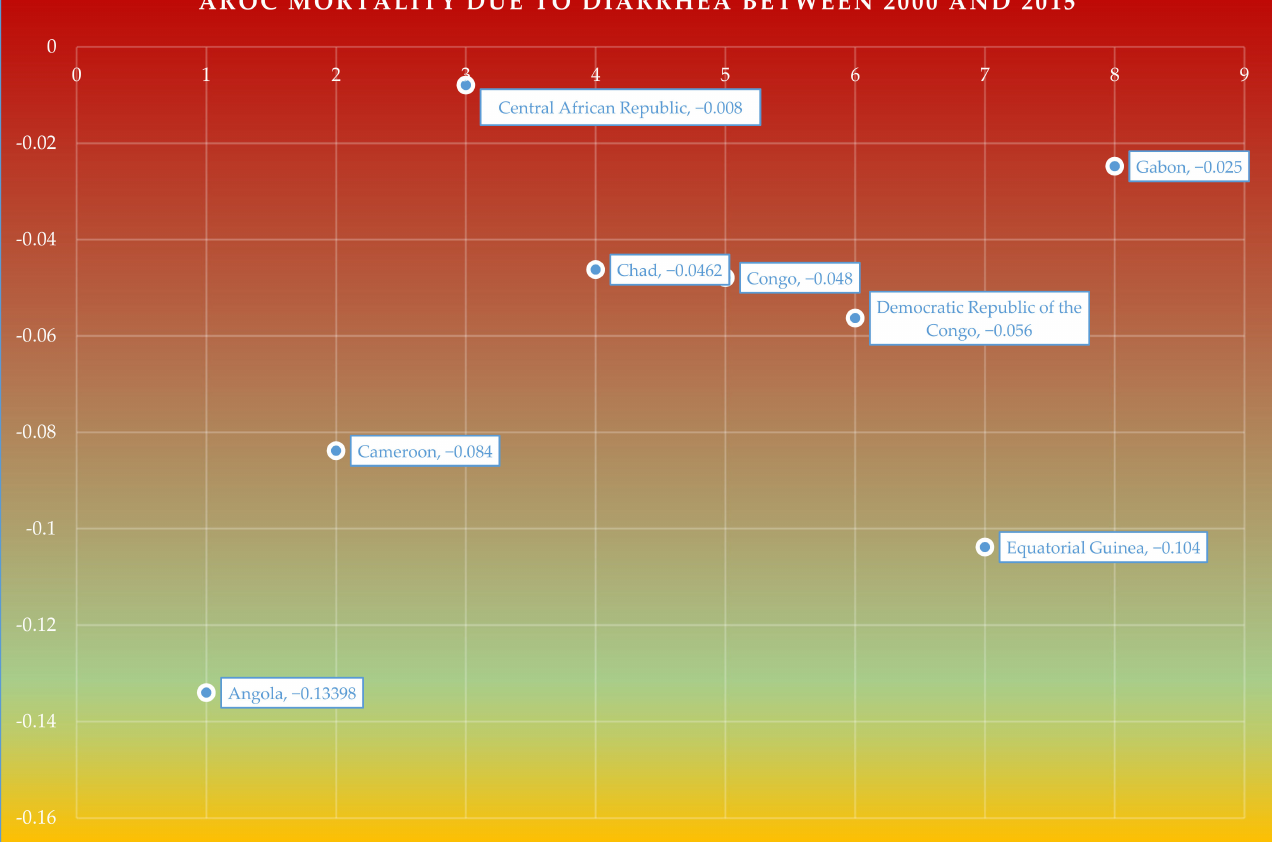
Figure 6. Adjusted Rate of Change (AROC) for mortality due to diarrhea between the years 2000 and